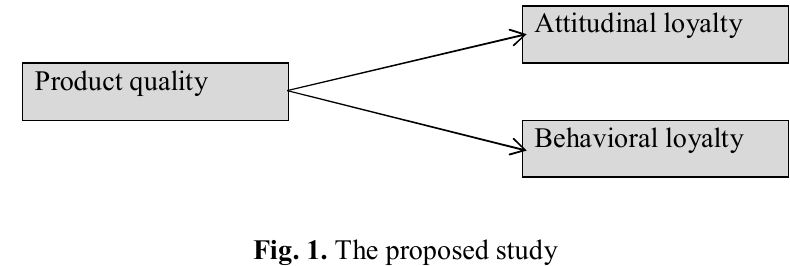
Fig. 1. The proposed study